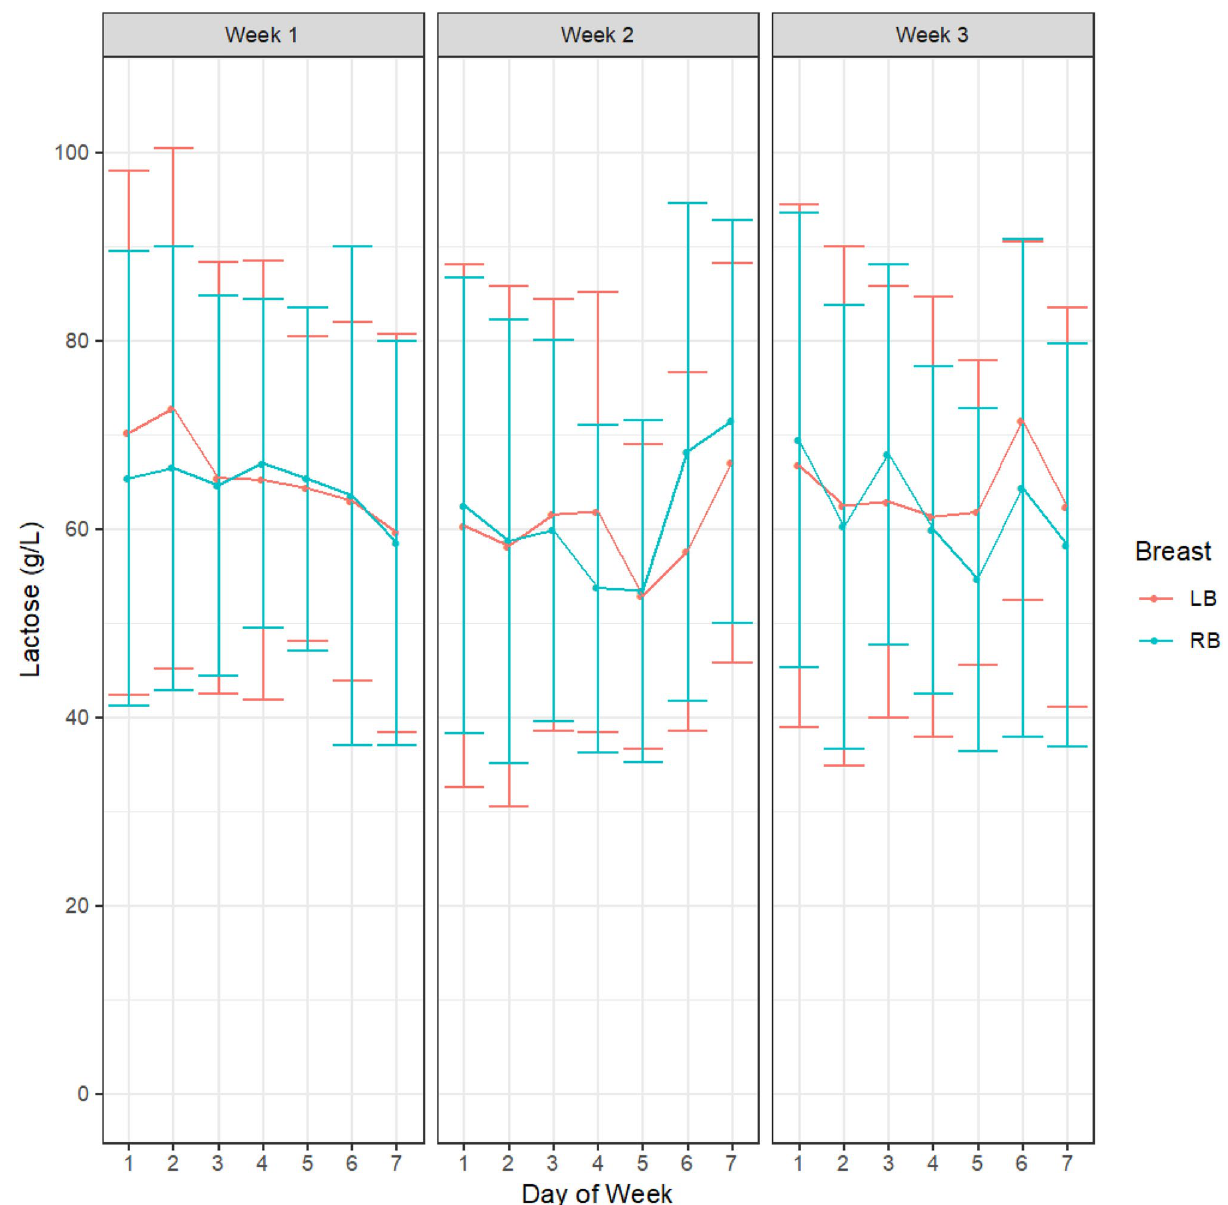
Figure 3. HM lactose concentrations in HM within participants across the days and between breasts for week 1, week 2 and week 3. Left breast (LB, red); Right breast (RB blue). Values are shown as mean and standard